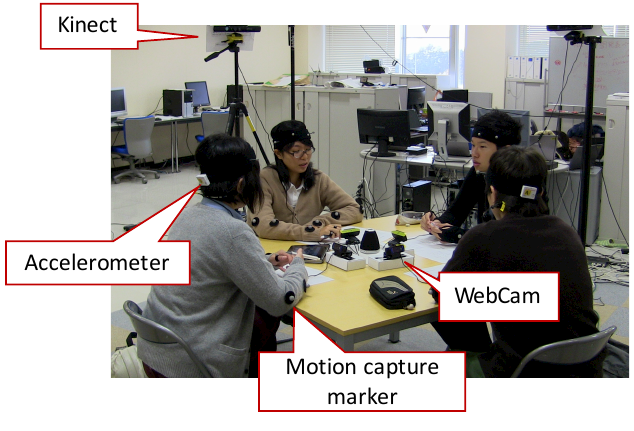
Figure 1. Setup of the data corpus recording